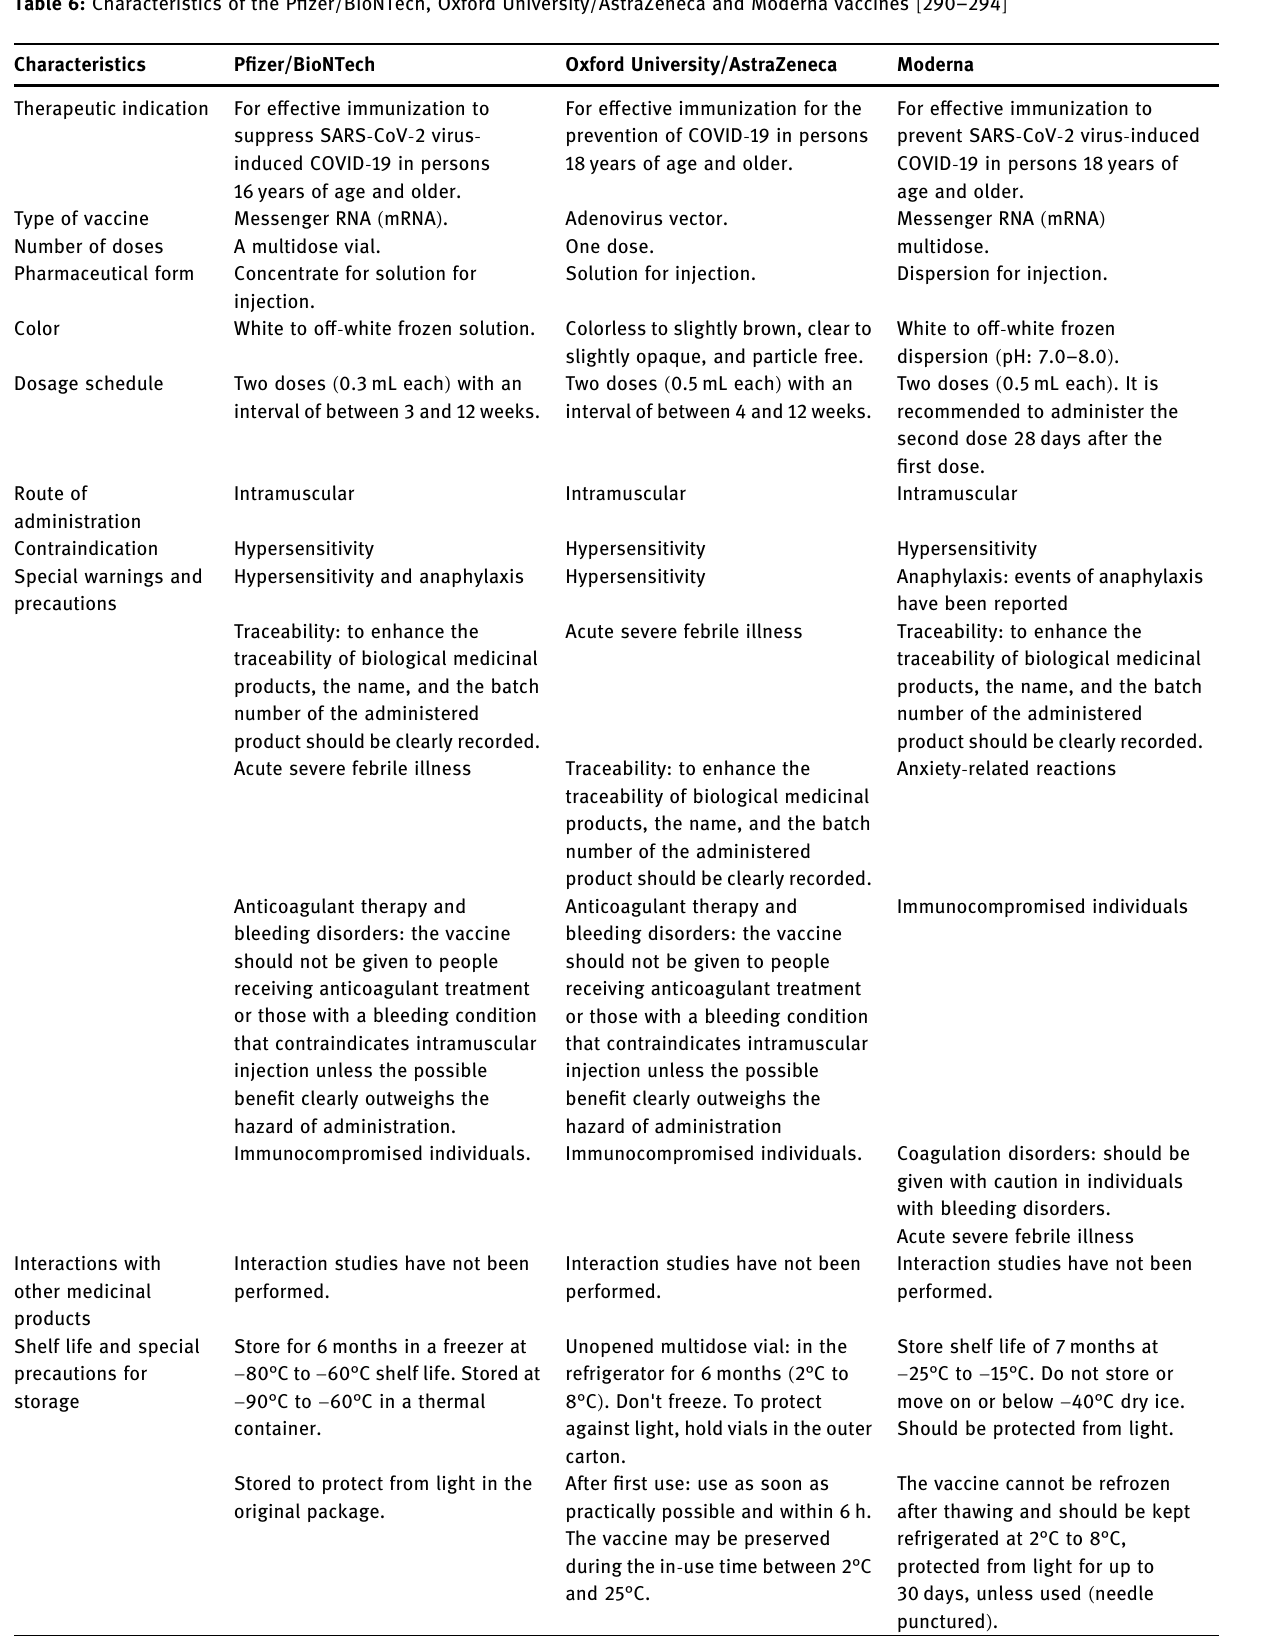
Table 6: Characteristics of the P fi zer/BioNTech, Oxford University/AstraZeneca and Moderna vaccines [ 290 – 294 ]